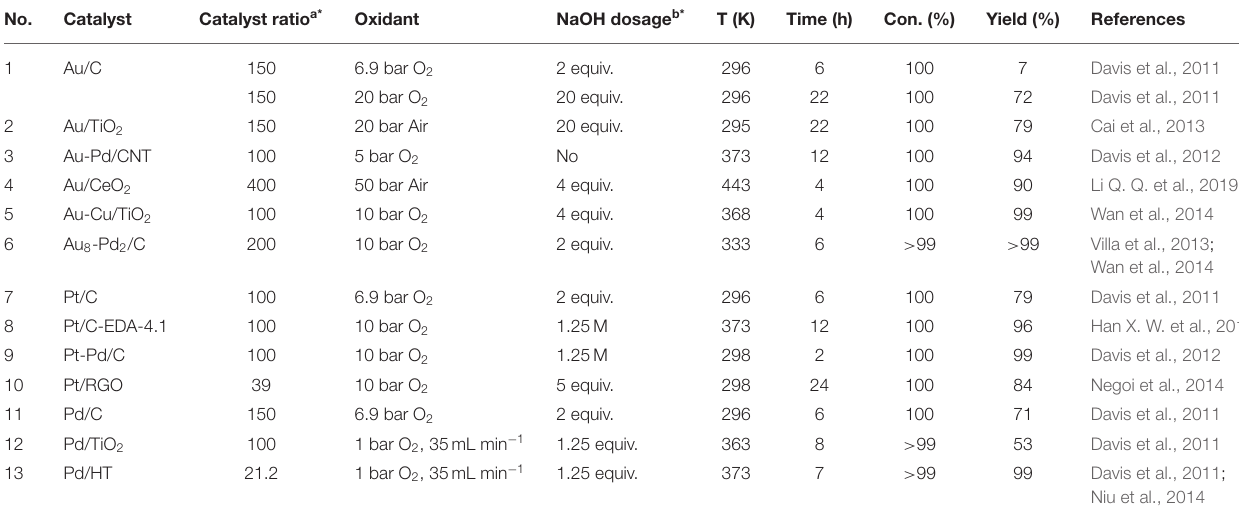
TABLE 1 | Several catalysts for the oxidation of HMF into FDCA.